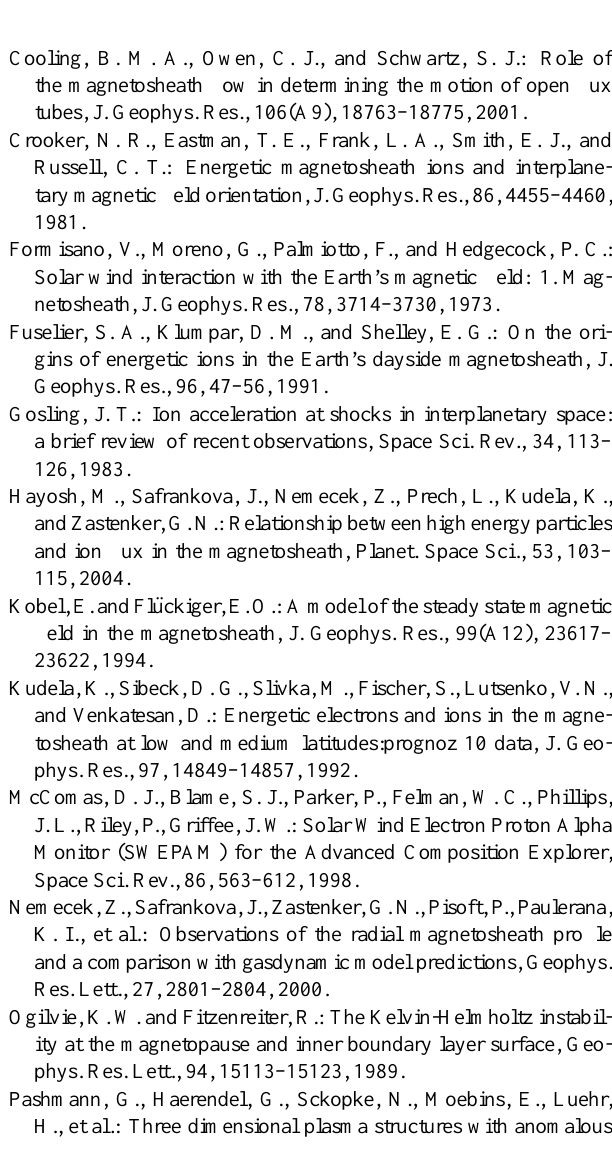
Fig. 18. Scatter plots of (a) total pressure in the magnetosheath and (b) magnetopause ratio versus particle flux (PF30) for 2 January 2003. The panels show how total magnetosheath pressure and the magnetopause ratio vary with increasing energetic particle